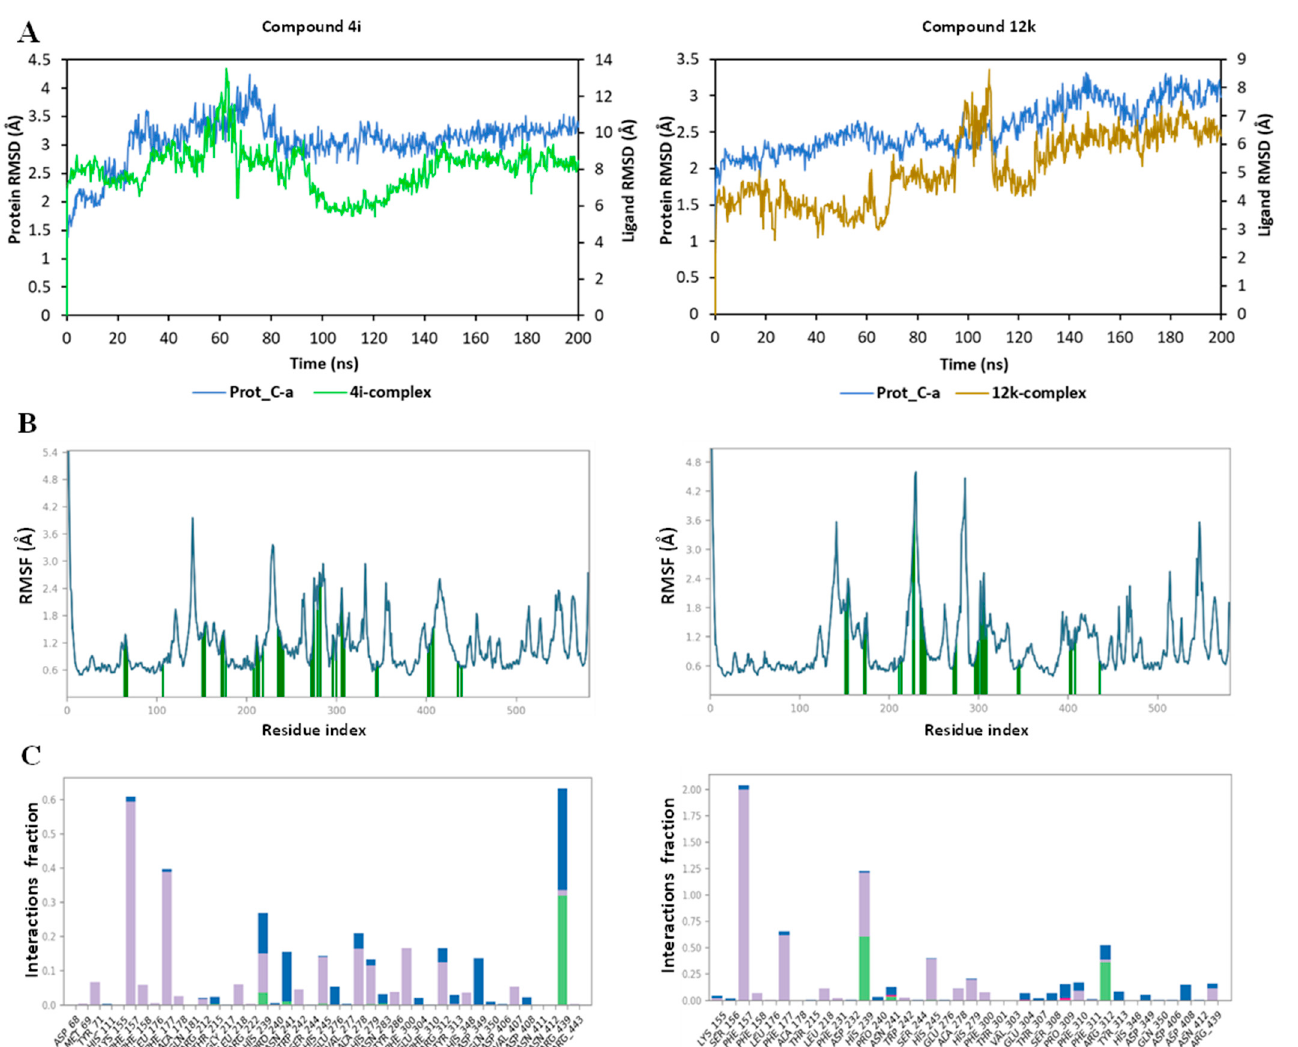
Figure 7. MD simulation trajectory analysis of compounds 4i and 12k . ( A ) RMSD and ( B ) RMSF plots. ( C ) Protein–ligand interactions over the 200 ns trajectory.